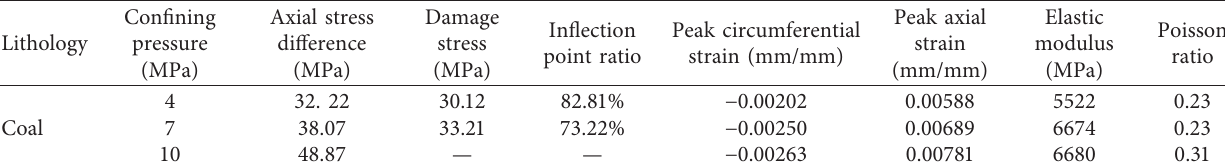
Table 1: Triaxial compression test results.